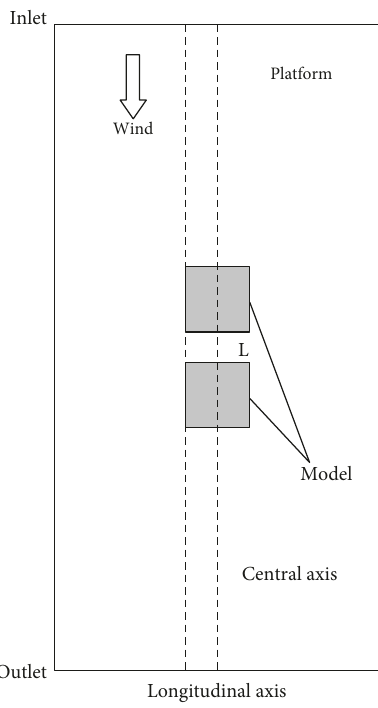
Figure 8: Two-holed test models. Table 2: Physical properties of particles and other main